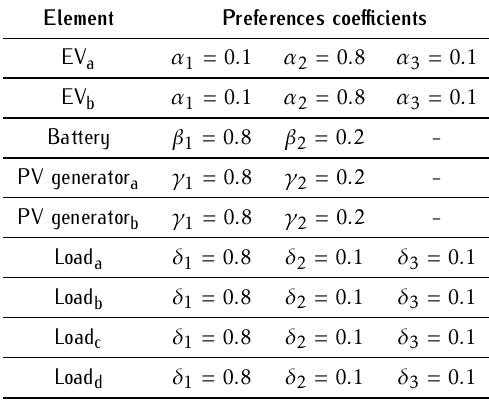
Table 2. Parameters of grid elements for scenario (b) Element